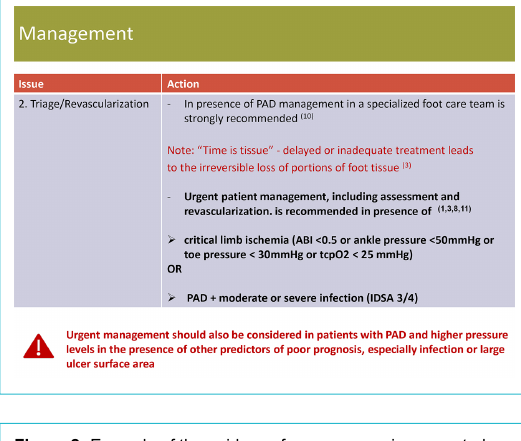
Figure 1: Screenshot from the guidance on the management of acute severe peripheral arterial disease.